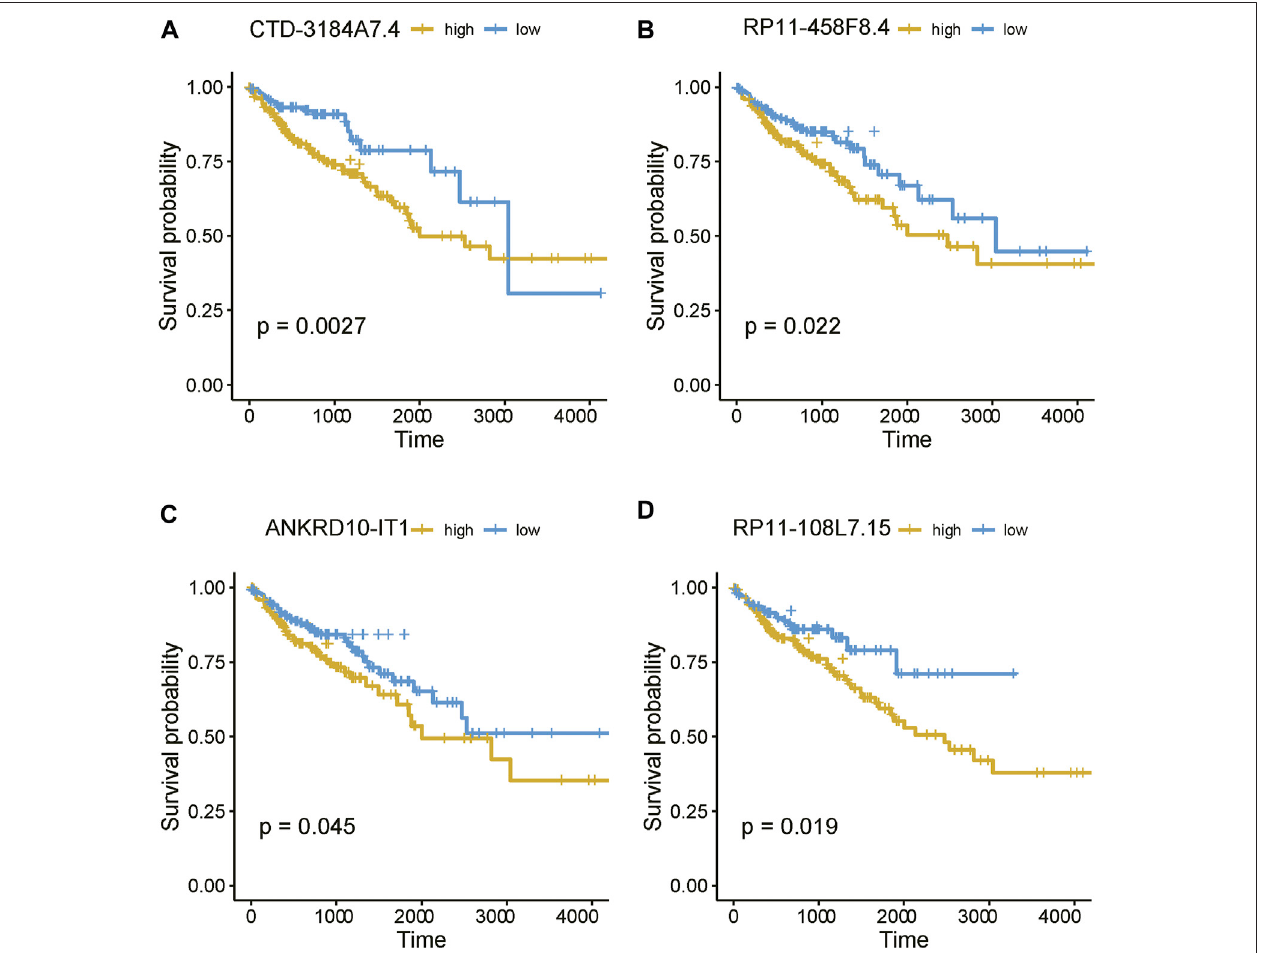
FIGURE6| Theprognosticvaluesofthefour m6A-related lncRNAs. TheKaplan-Meier curves forthesampleswithhigh and lowexpression of (A) CTD-3184A7.4, (B) RP11-458F8.4, (C) ANKRD10-IT1, and (D) RP11-108L7.15.